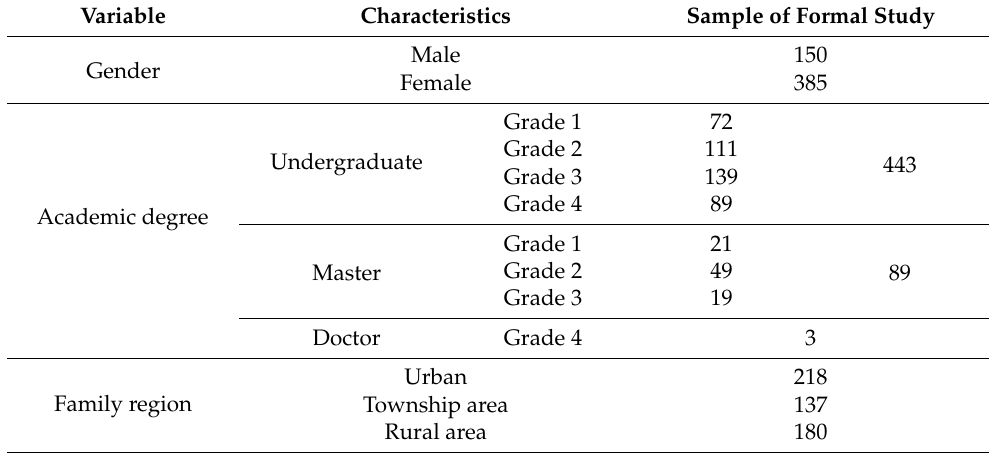
Table 1. Characteristics of the study